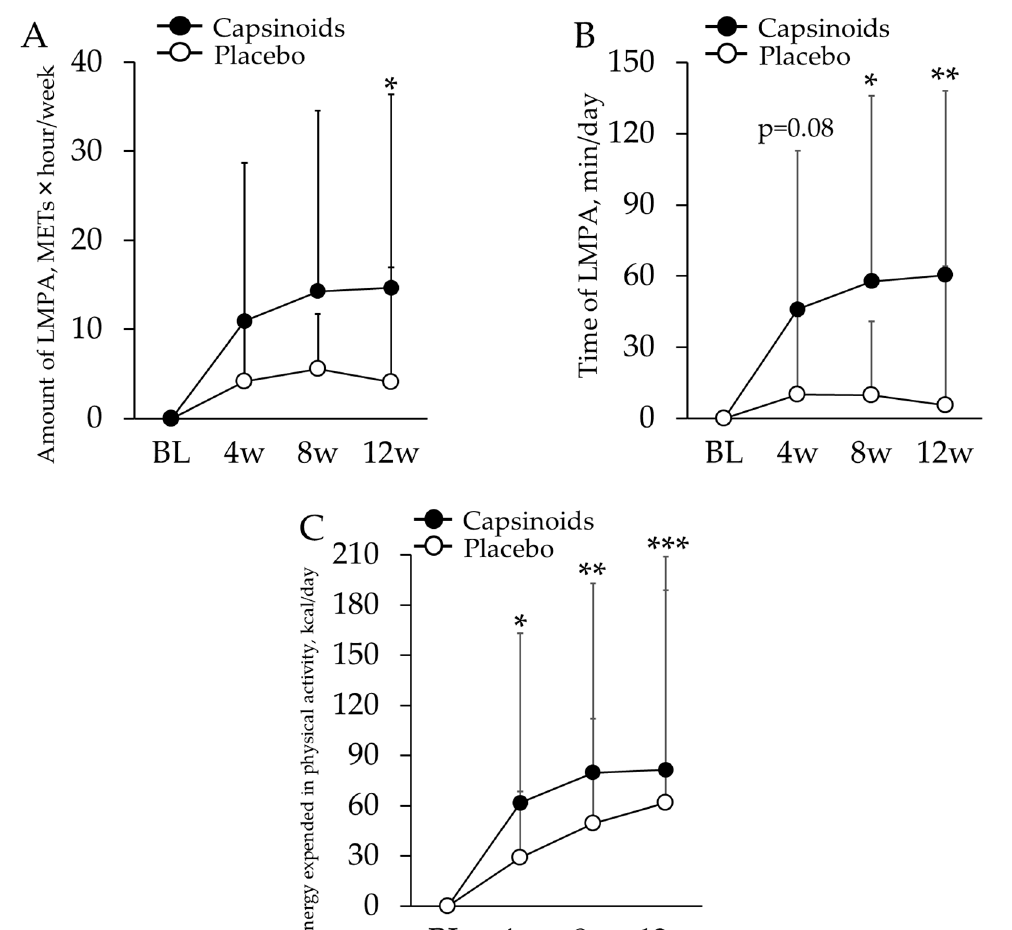
Figure 2. Changes from BL in the amount ( A ) and the time ( B ) of LMPA, and the energy expended in physical activity ( C ) in sedentary/inactive subjects. The values are the difference from baseline value. The error bars indicate standard deviation. Capsinoids group showed significant increase in these measurements of PA (* p < 0.05; ** p < 0.01; *** p < 0.001).